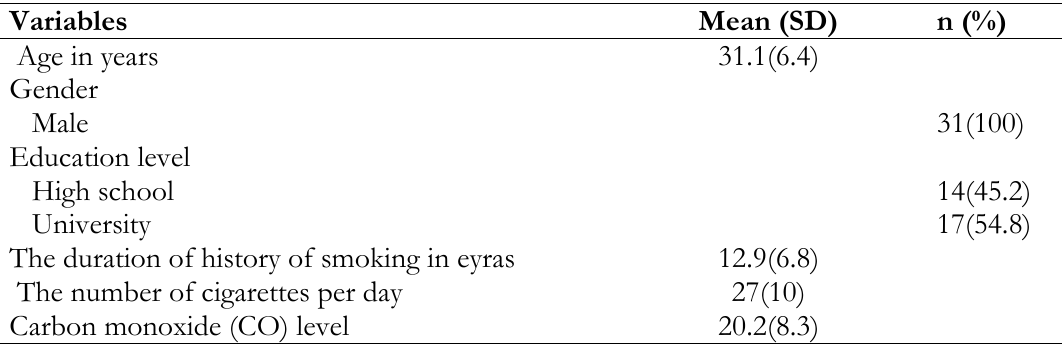
Table I. The characteristics of participants (n = 31)